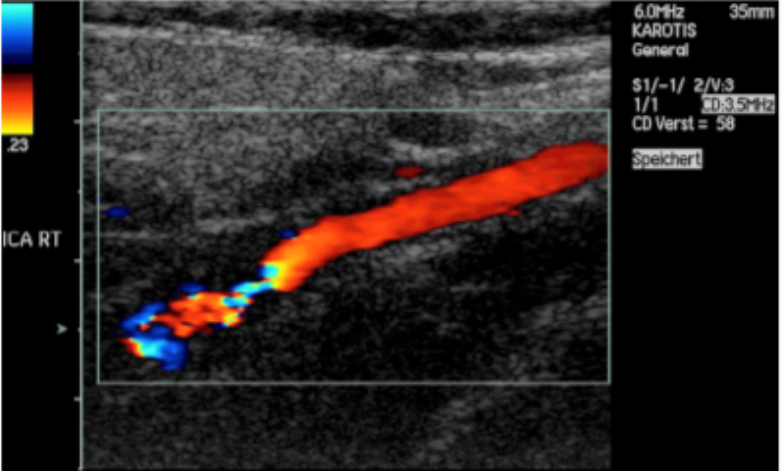
Figure 3. Example of color Doppler image showing high-grade stenosis of internal carotid artery